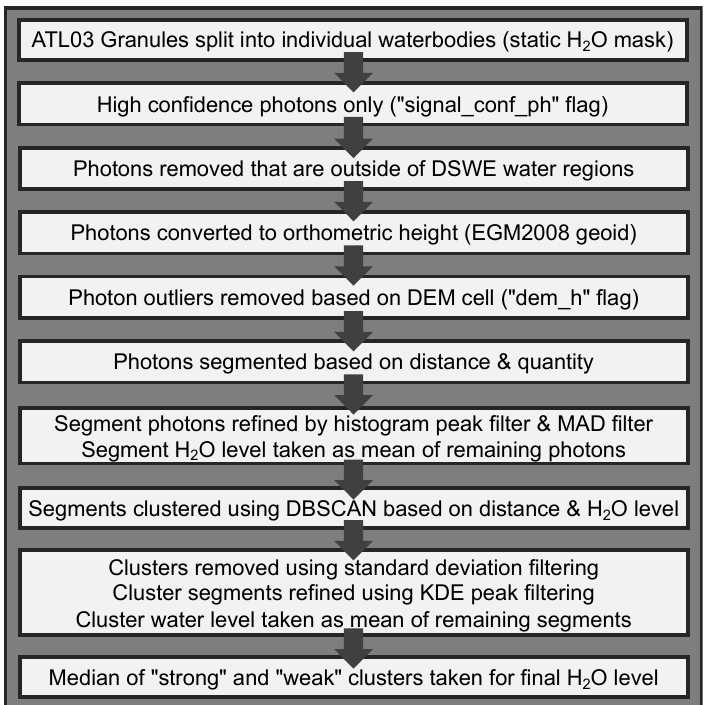
Figure 2. A flowchart highlighting the generalized ATL03 processing methodology as described in Section 2.3.